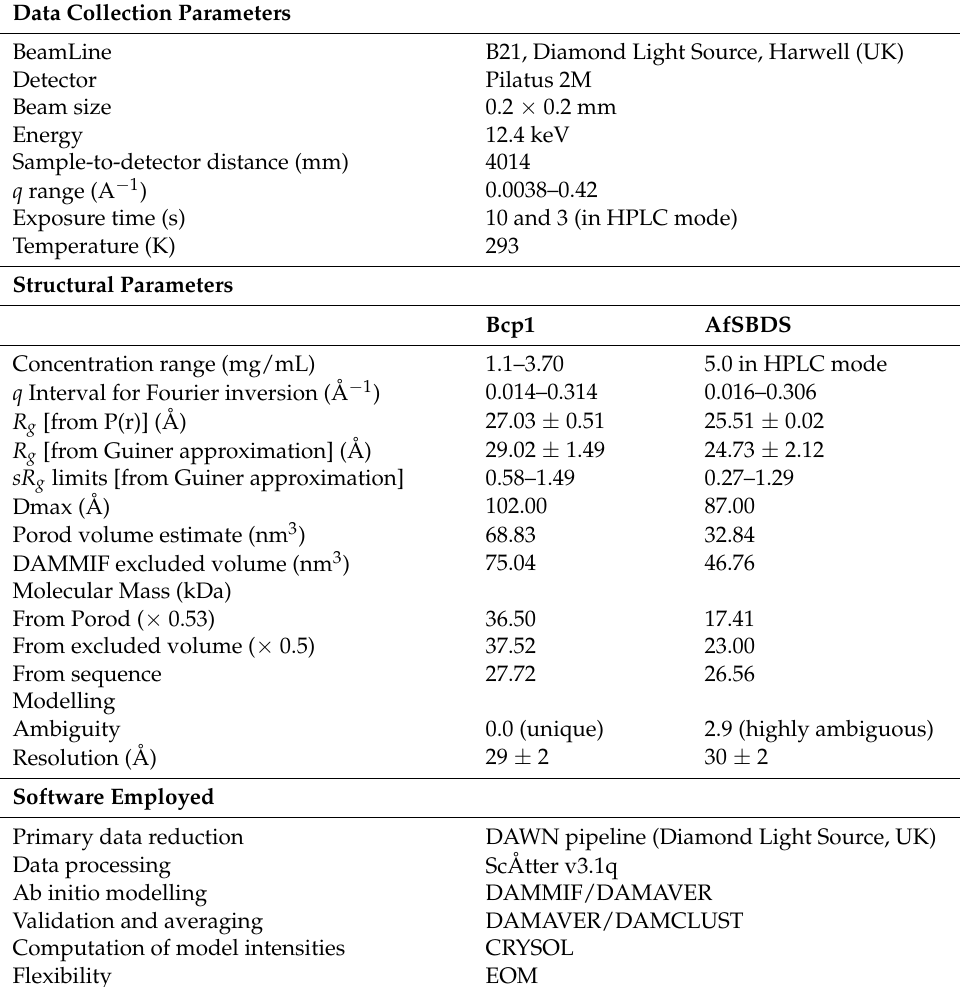
Table 2. SAXS data collection and experimental parameters for the proteins Bcp1 and Archaeoglobus fulgidus